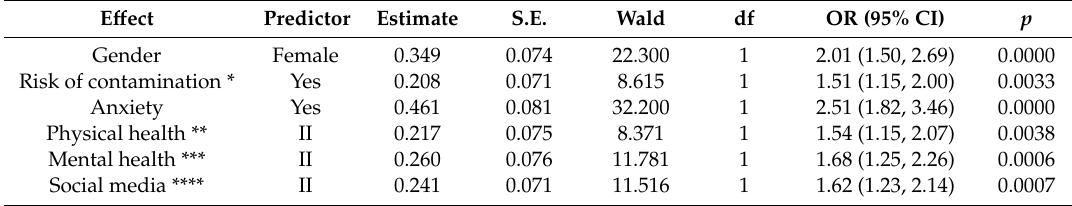
Table 10. Prediction of awake bruxism (AB) aggravation in